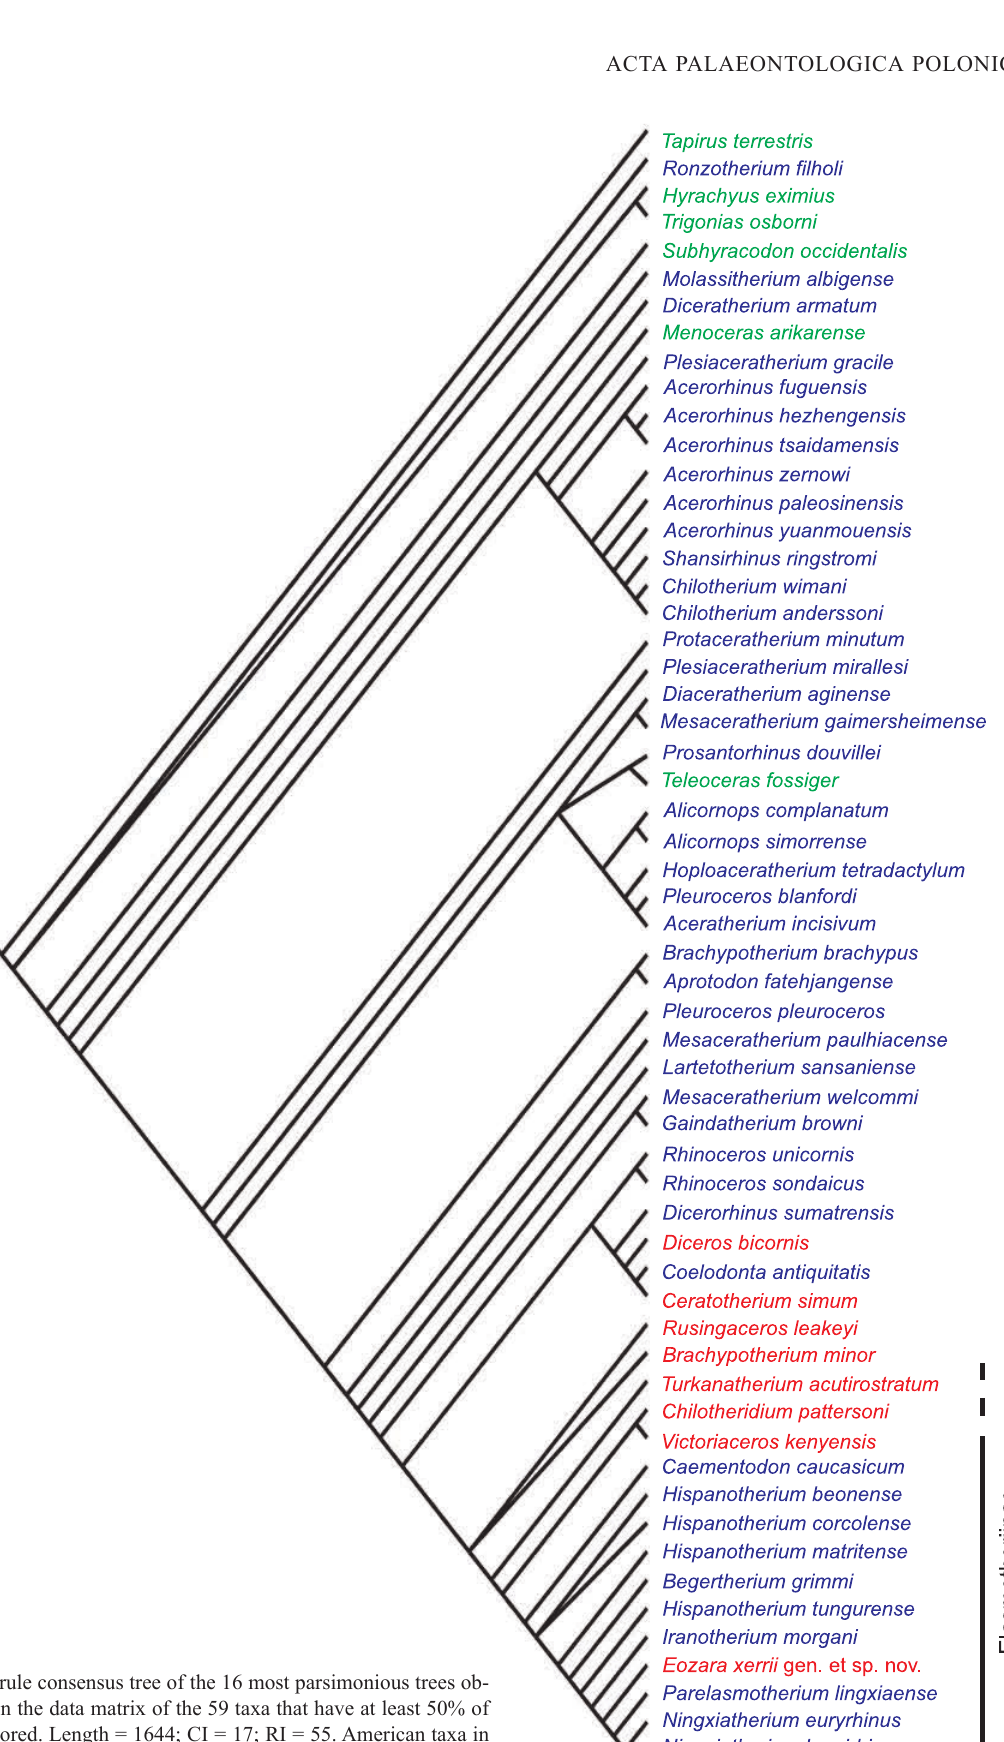
Fig. 4. Majority rule consensus tree of the 16 most parsimonious trees ob- tained by TNT on the data matrix of the 59 taxa that have at least 50% of the characters scored. Length = 1644; CI = 17; RI = 55. American taxa in green, Eurasian taxa in blue, African taxa in red. The dashed line extends to the taxa that might belong to the Elasmotheriinae as